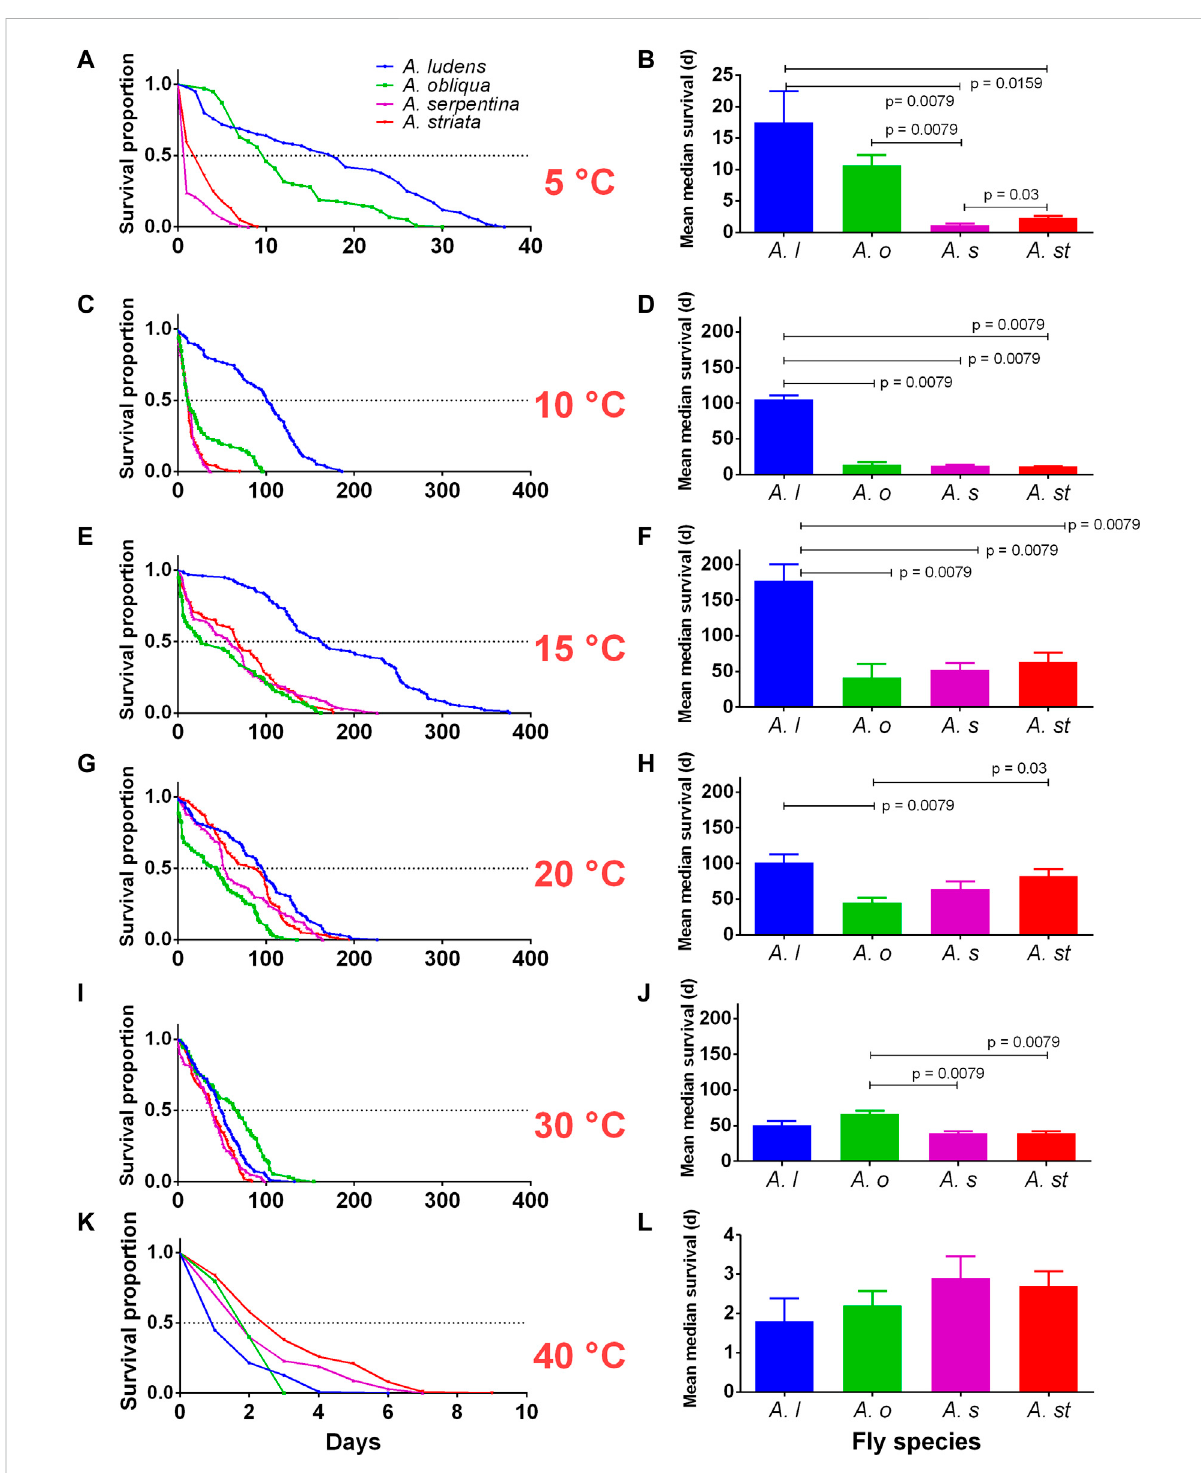
FIGURE 2 Adult survival (days) of four Anastrepha species ( A. ludens, A. obliqua, A. serpentina, and A. striata ) exposed to different temperatures (5, 10, 15, 20, 30,40 ° C) in bioclimatic chambers. (A,C,E,G,I,K) Kaplan-Meier survival curves by temperature; the dotted horizontal line represents the mean of the medians of all replicates. (B,D,F,H,J,L) Means ± SE of median survival (days) of fi ve replicates (cage with fl ies) per species. Horizontal bars representpairwisecomparationswithMann-Whitneytestswhencleardifferenceswerenoticed.Weleftthedatafor45 ° Coutasinallspeciesno adult survived more than 24